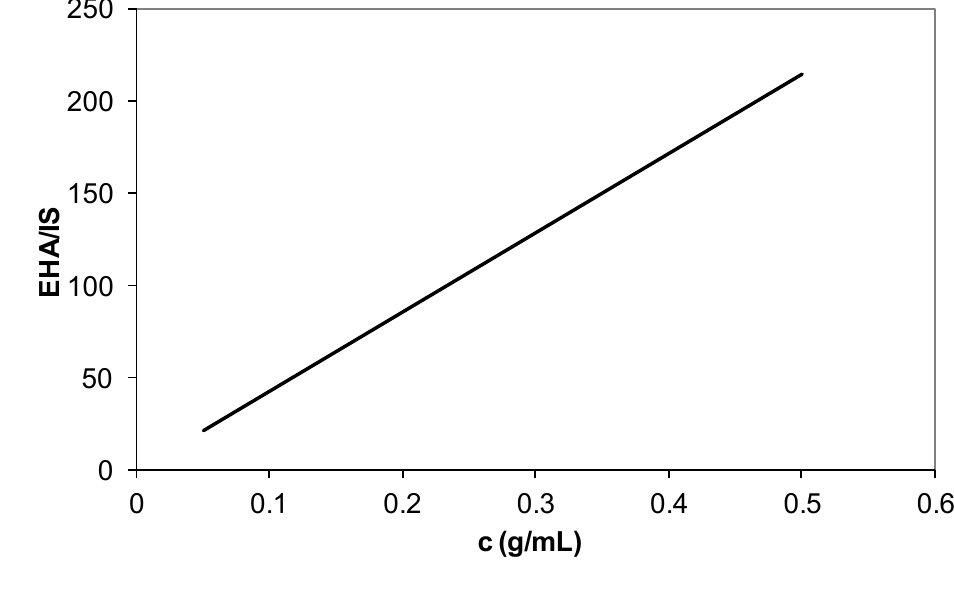
Figure 11. Calibration curve of ethyl hexyl acrylate (EHA) comonomer. IS: Internal